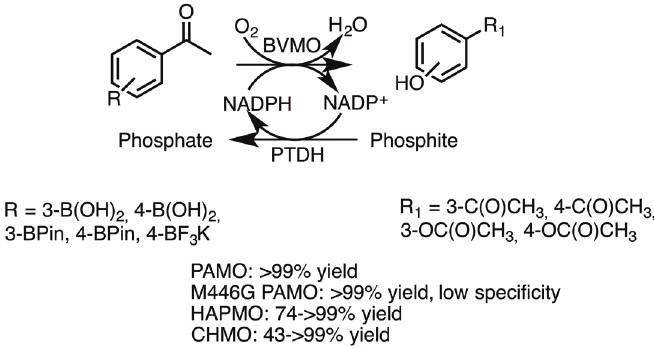
Figure 49 - Oxidation of boron-containing acetophenones by Baeyer- Villiger Monooxygenases.